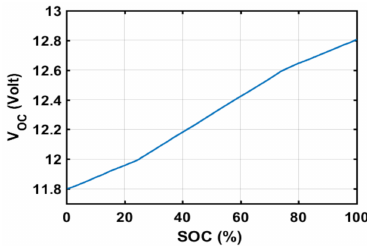
Figure 1. Open circuit voltage (V OC ) vs. state of charge (SOC) for the employed 12 V Lead-Acid